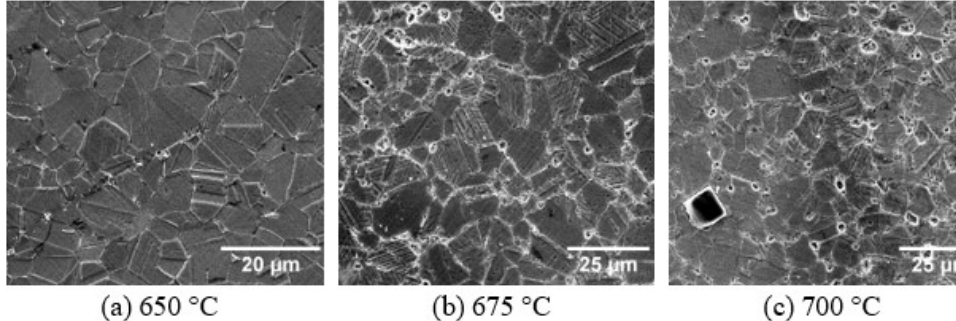
Figure 13. Cross section microstructure of Inconel 718 after creep test.